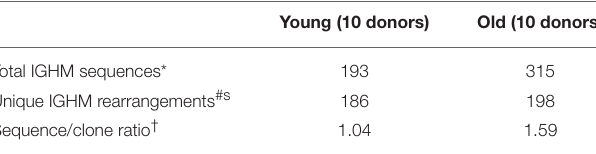
TABLE 1 | Numbers of IGHM sequences produced by single-cell PCR.